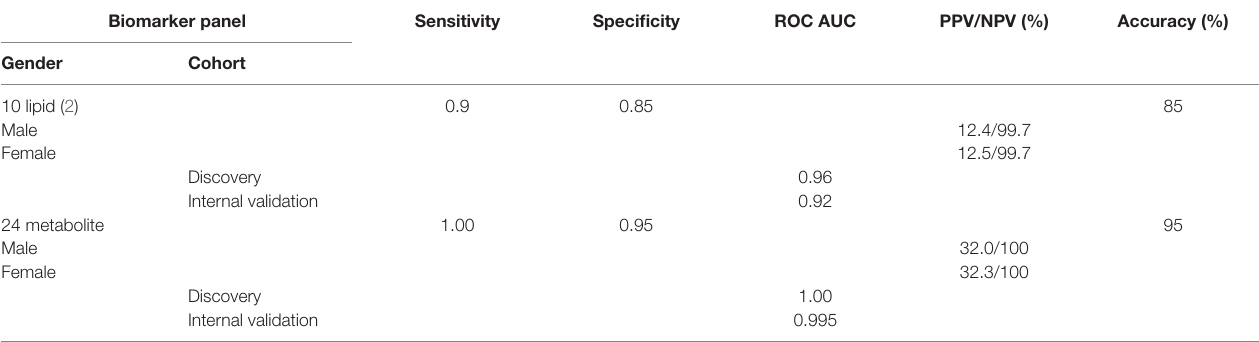
TaBle 4 | Biomarker panel comparisons. Biomarker